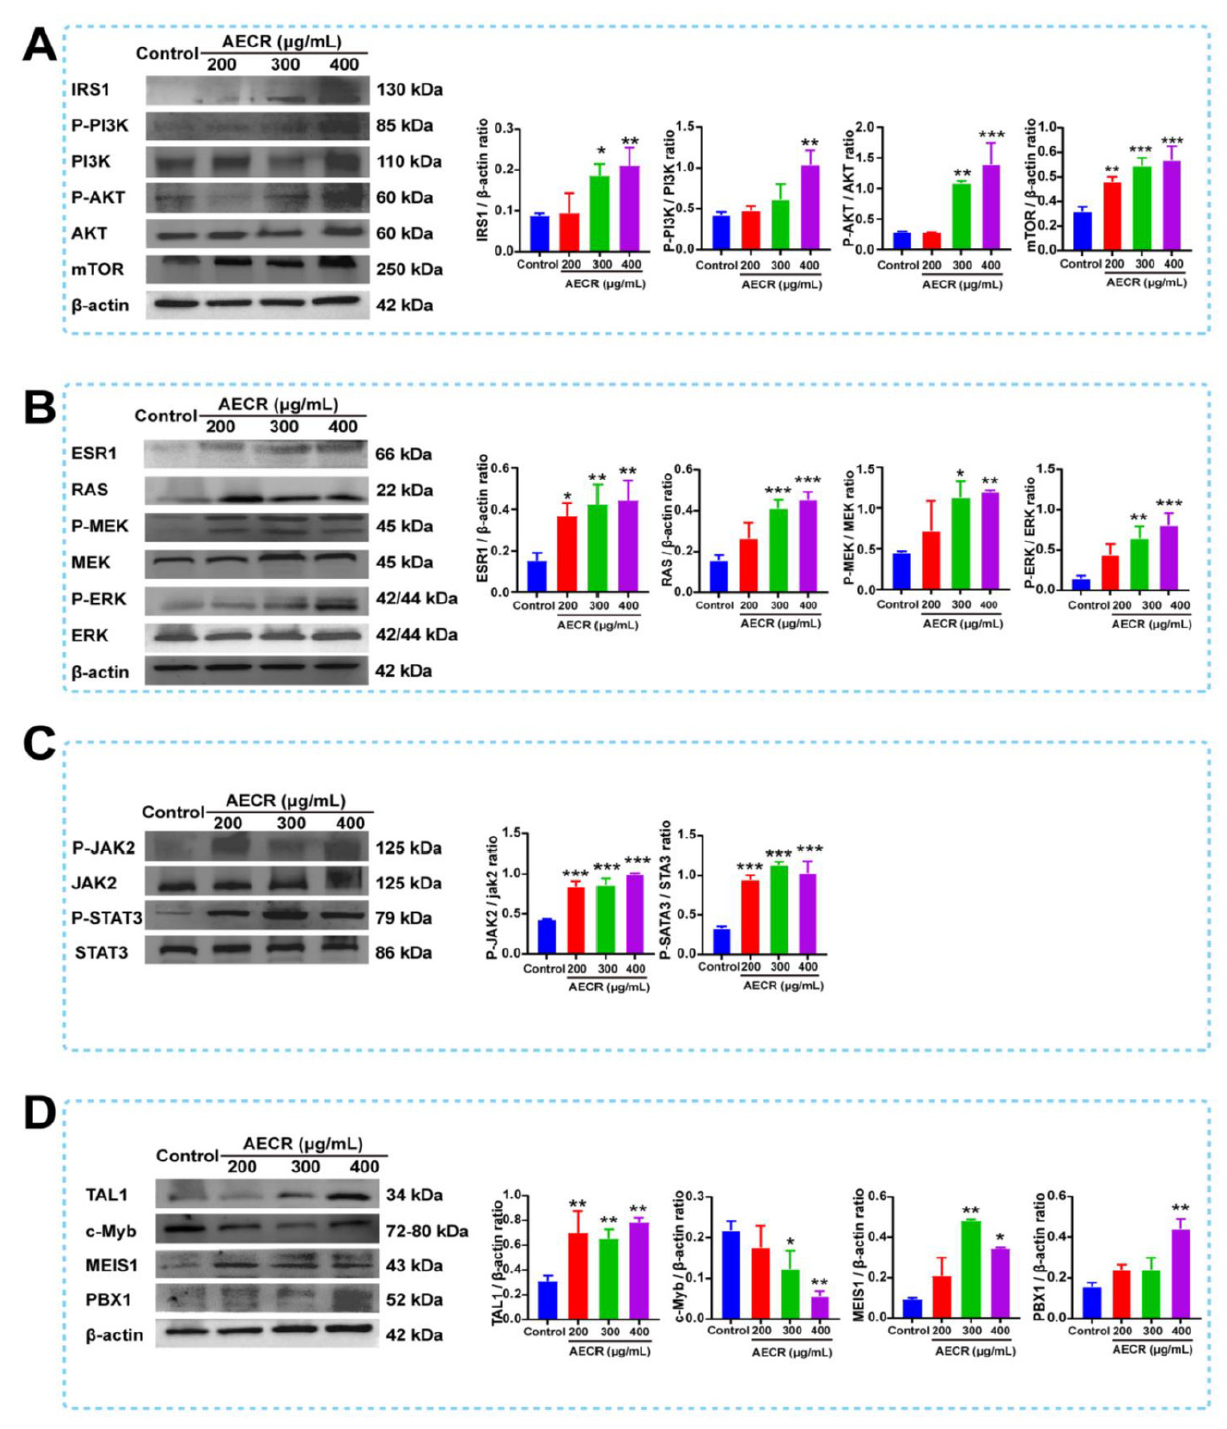
Figure 7. After incubating K562 cells with AECRs (200, 300, and 400 µ g/mL) for 4 days, the expression of these proteins were determined by Western blot. These proteins were ( A ) IRS1, PI3K, AKT, and mTOR; ( B ) ESR1, RAS, MEK, and ERK; ( C ) JAK2 and STAT3; ( D ) TAL1, c-Myb, MEIS1, and and PBX1. On the right, this statistical histogram represents the protein level in each group. The values represent the means ± standard deviations (n = 3). * p < 0.05, ** p < 0.01, *** p < 0.001 versus the control group. AECRs: aqueous extracts of Cibotii rhizoma.